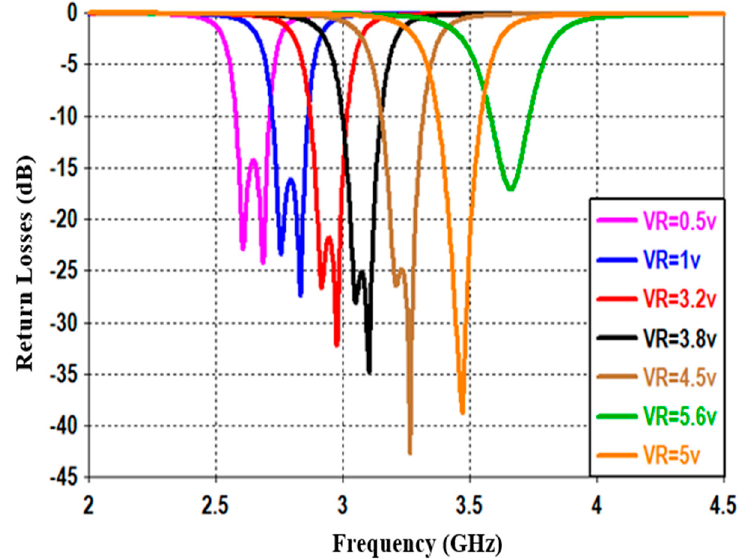
Figure 13. Measured return losses with different DC reverse bias voltages for the presented reconfigurable filter.